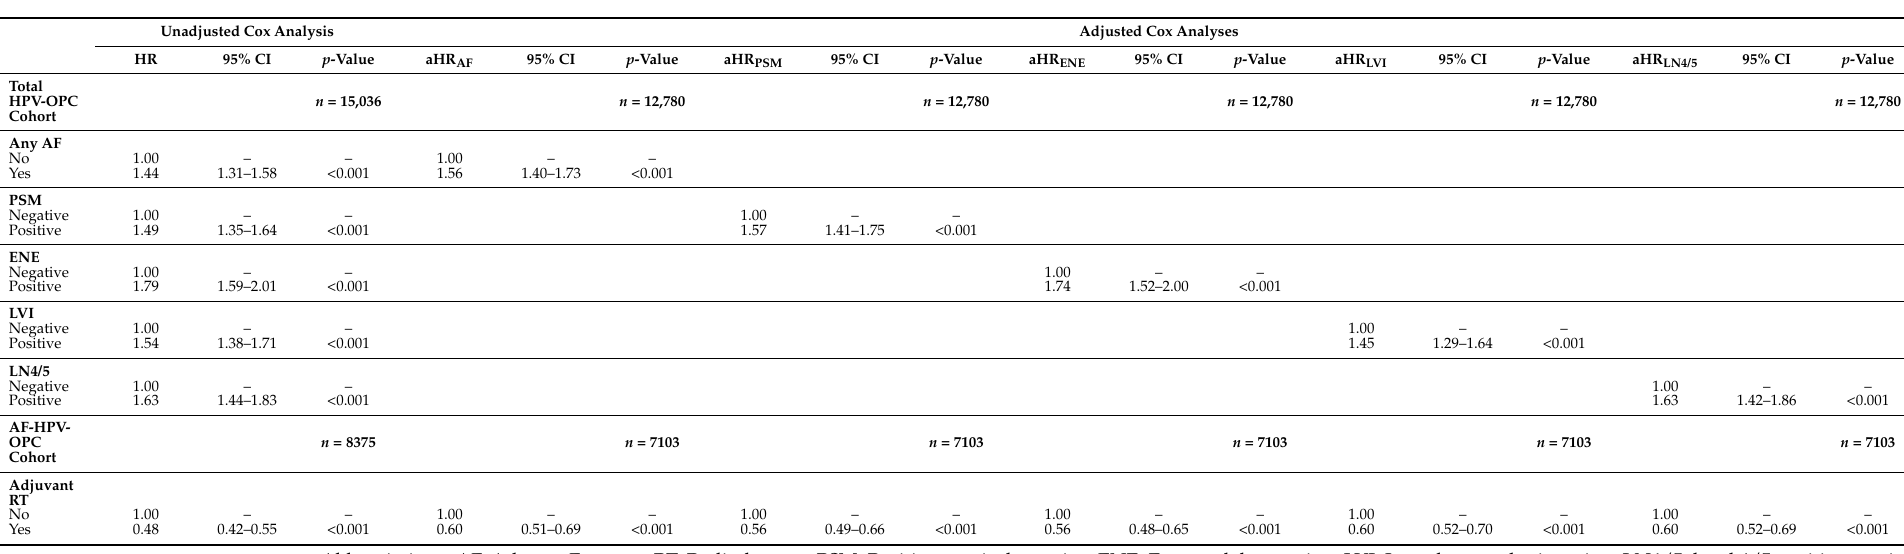
Table 2. Cox Proportional Hazards Models of Adverse